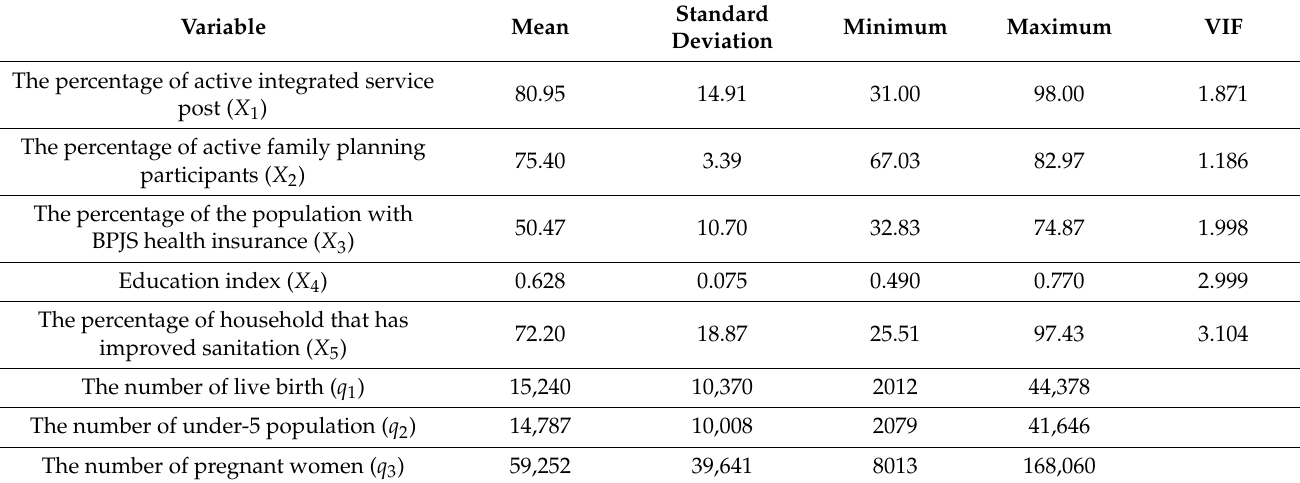
Table 2. Summary statistics of predictor variables and exposure variables.